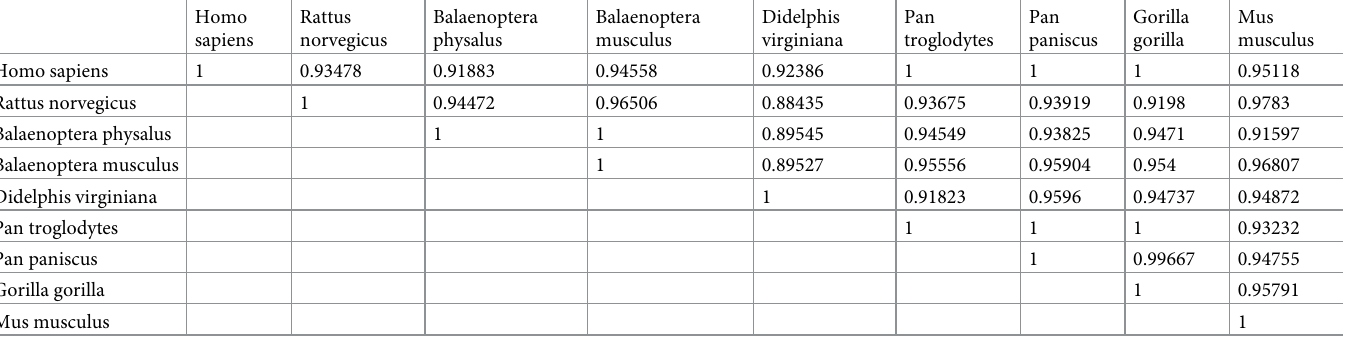
Table 11. The parameter Positive Predictive Value (PPV) of the HELIOS method with referencing the Smith-Waterman algorithm in the accuracy measurement of classification output. The assumed dataset is the “Nine ND5 protein sequences dataset” [53] in this study.